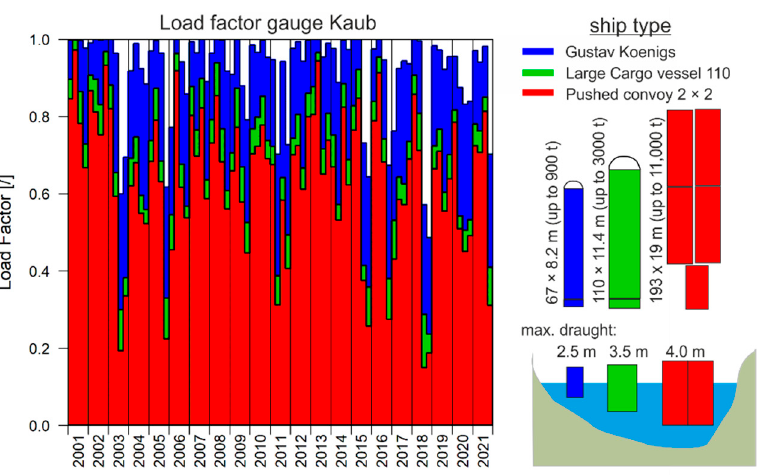
Figure 1. Load factor of three relevant vessel types at the Rhine bottleneck at gauge Kaub for the period of 2001 to 2021.